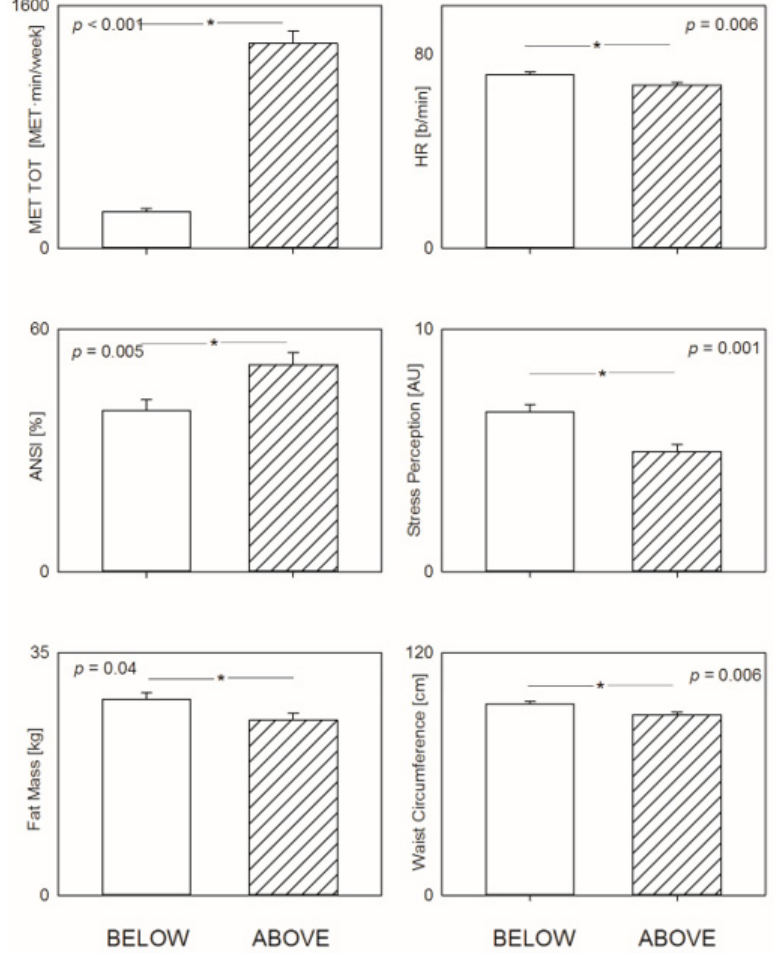
Figure 2. Differences in the main selected parameters between breast cancer survivors who sponta- neously met (ABOVE) current physical activity goals and those who did not (BELOW). Physically active patients showed a better autonomic, metabolic and psychological profile. ET TOT = total weekly activity volume, * = p significance.